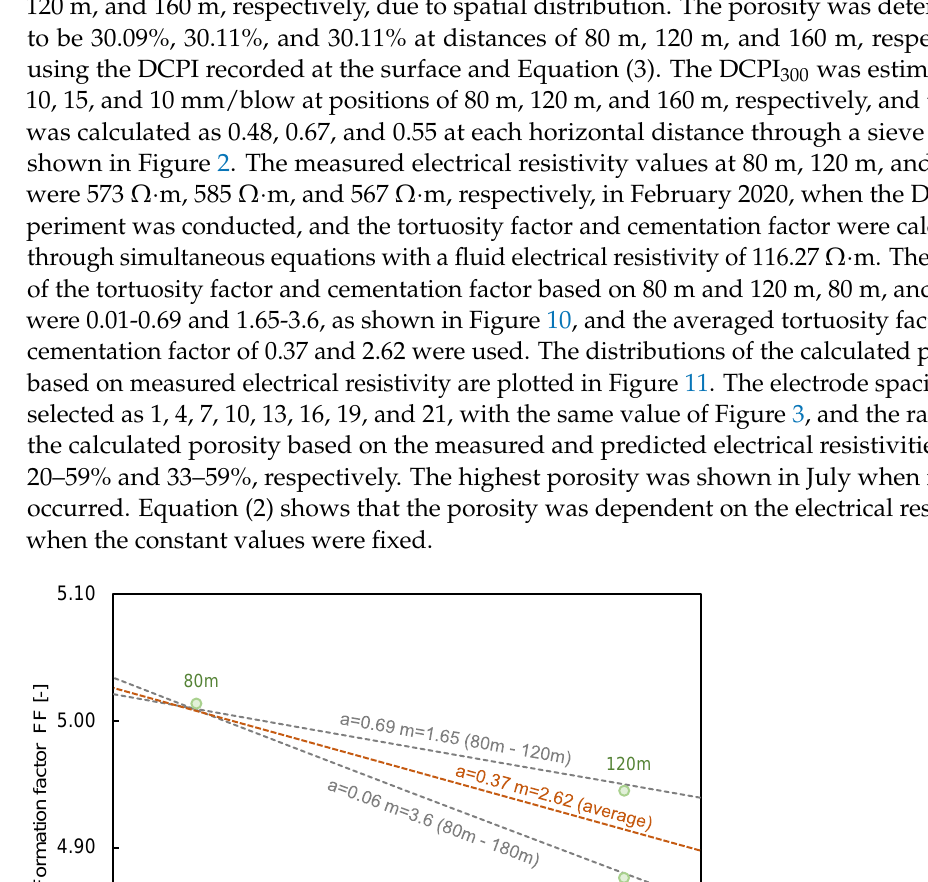
Figure 10. Relationship between the formation factor and porosity for the extracted specimens. Here, a and m denote the tortuosity and cementation factors.